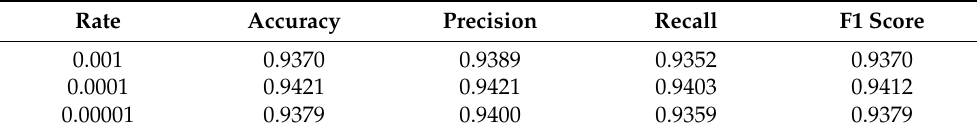
Table 2. Performance evaluation for the training rate of the model. Rate